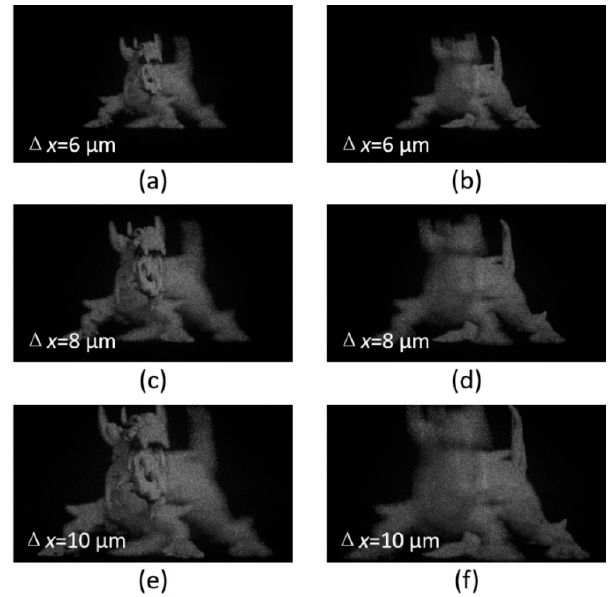
Figure 5. Numerical reconstructions of CGHs with different sampling rates. ( a ), ( c ) and ( e ) focus on the head; ( b ), ( d ) and ( f ) focus on the tail.